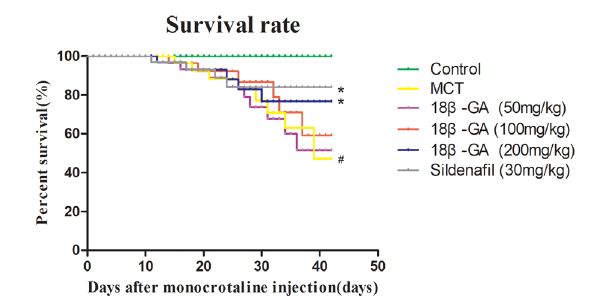
FIGURE 3 | Survival analysis of all rats. Data are expressed as mean ± SEM ( n = 20). # p < 0.05 vs. control group, ∗ p < 0.05 vs. MCT group. MCT, monocrotaline; 18 β -GA, 18 β -glycyrrhetinic